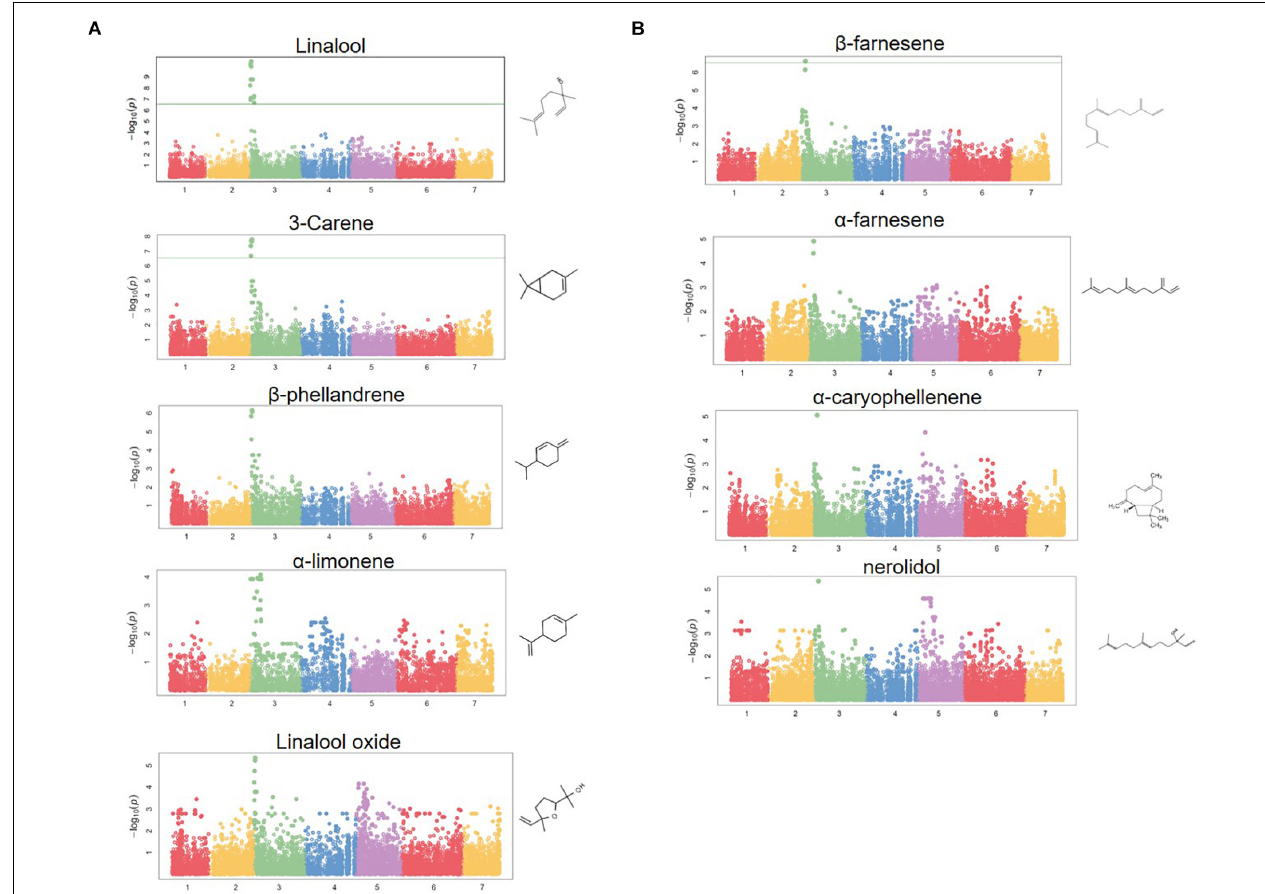
FIGURE 4 | Terpene volatile QTL in strawberry fruit. (A) QTL Manhattan plots for the monoterpenes linalool ( r 2 = 0.15, p = 4.2e–11), 3-carene ( r 2 = 0.09, p = 1.2e–8), β -phellandrene ( r 2 = 0.21, p = 7.0e–7), α -limonene ( r 2 = 0.06, p = 7.0e–7), linalool oxide ( r 2 = 0.08, p = 4.4e–6). (B) The sesquiterpenes β -farnesene ( r 2 = 0.12, p = 2.4e–7), α -farnesene ( r 2 = 0.16, p = 1.6e–6), α -caryophellene ( r 2 = 0.10, p = 8.9e–6), and nerolidol ( r 2 = 0.09, p = 4.3e–6). Chemical structures are shown for each